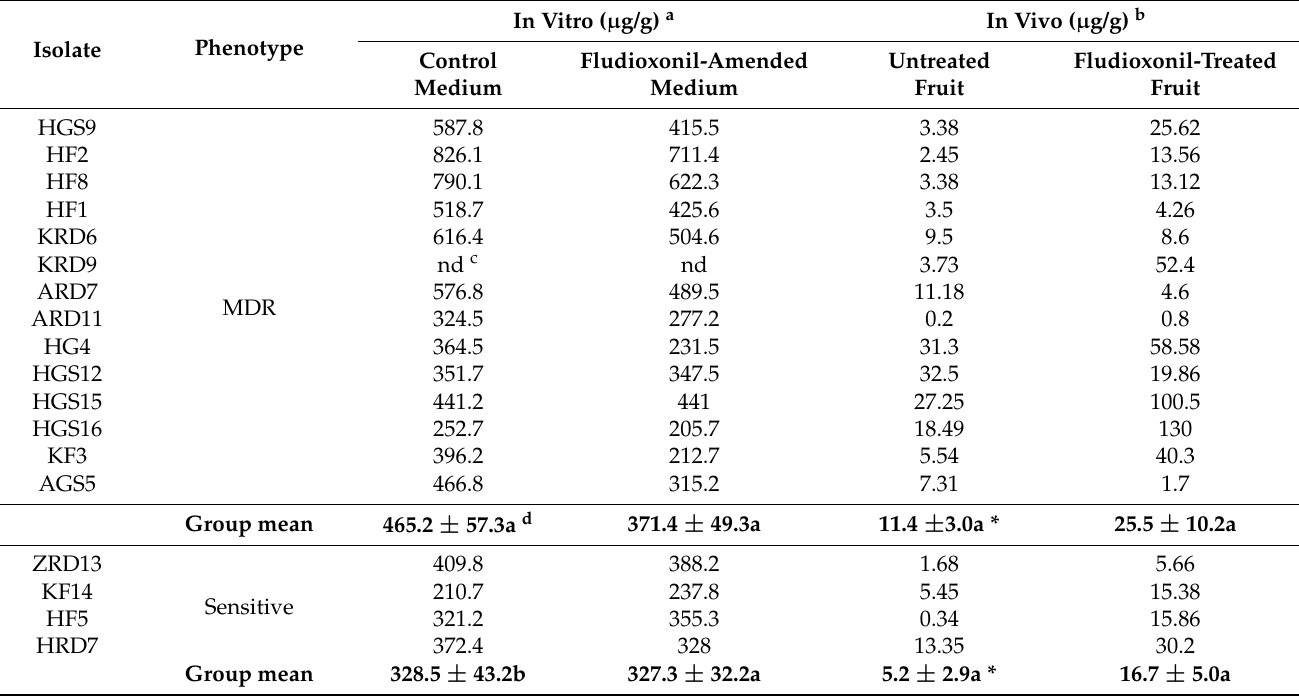
Table 2. Mean patulin production ( µ g/g), on PDA media (in vitro) and on artificially inoculated apple fruit (in vivo) of Penicillium expansum MDR and sensitive isolates in the absence or presence of the fungicide